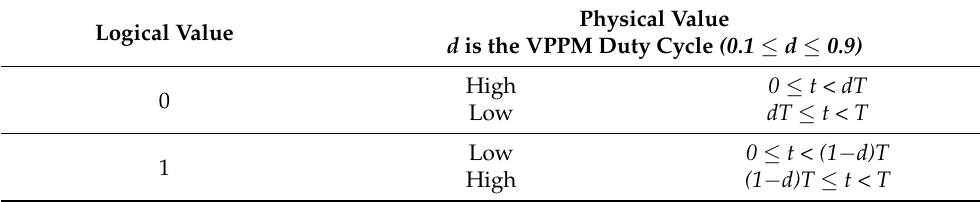
Table 2. Definition of data mapping for VPPM mode